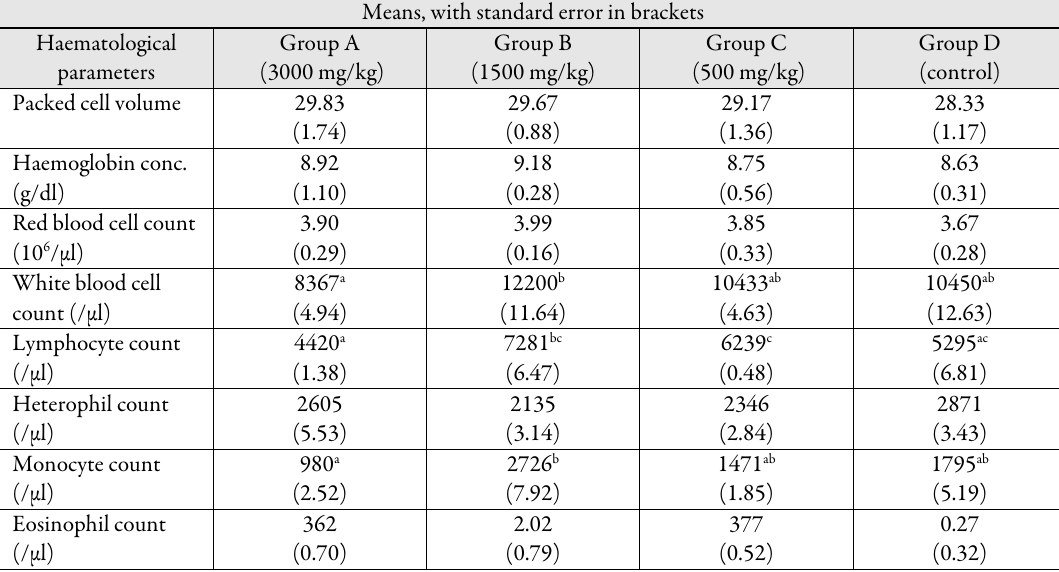
Table 2. Haematological parameters of cockerels given varied doses of Anarcadium occidentale root